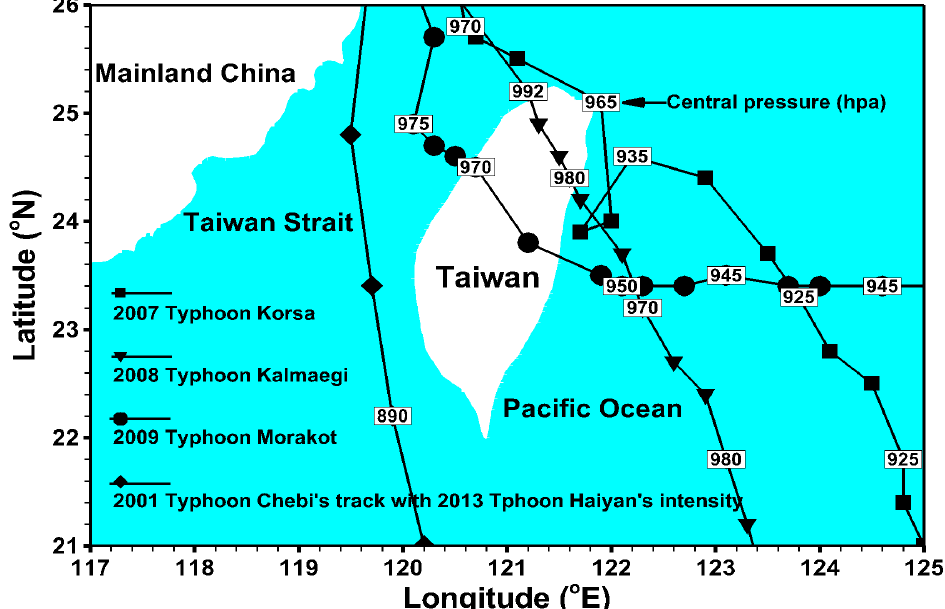
Figure 4. Typhoon tracks for model validation (Typhoon Krosa, Typhoon Kalmagei, and Morakot) and model application (Typhoon Chebi). The value in the typhoon track represents center pressure (mb). Cyan color and white color represent the ocean and land,